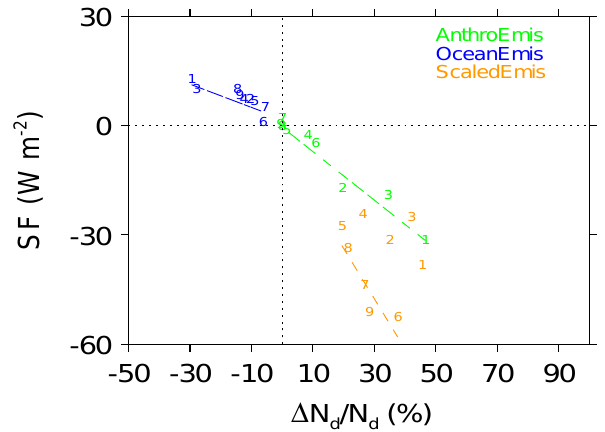
Fig. 8. Relationships between mean relative changes in droplet number concentrations and mean surface shortwave forcings (SF) due to ocean emissions (OceanEmis, blue), anthropogenic emis- sions (AnthroEmis, green), and scaled anthropogenic emissions (ScaledEmis, orange) within the model domain for the 9 regions defined in Fig. 1. The green and blue best fit lines are based on the green and blue data points, respectively, and the orange color line is based on orange data points for regions 5–9